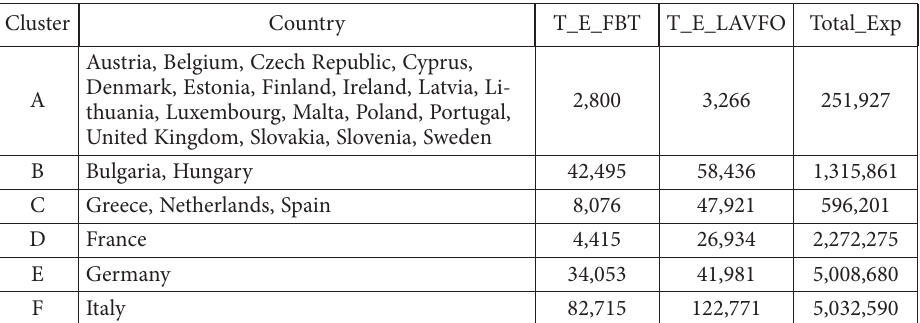
Table 7. EU states grouping according to the average volume at group level of Romania’s exports in 2007 (thousands euro) (source: authors’ own computations) Cluster